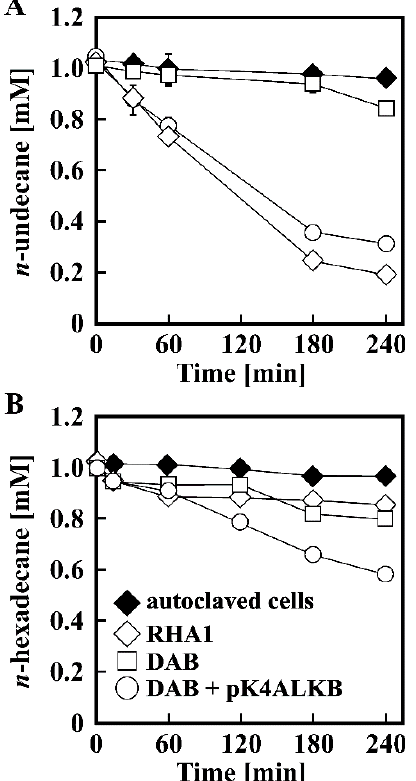
Figure 3. Degradation of n -undecane ( A ) and n -hexadecane ( B ) by RHA1, DAB, and DAB harboring pK4ALKB. 1 mM of each n -alkanes was incubated with the resting cells of RHA1 (open diamonds), DAB (open squares), DAB harboring pK4ALKB (open circles), and autoclaved cells of RHA1 (closed diamonds). The degradation activities were determined by GC-MS analysis. Each value is the average ± standard deviation of three independent experiments.